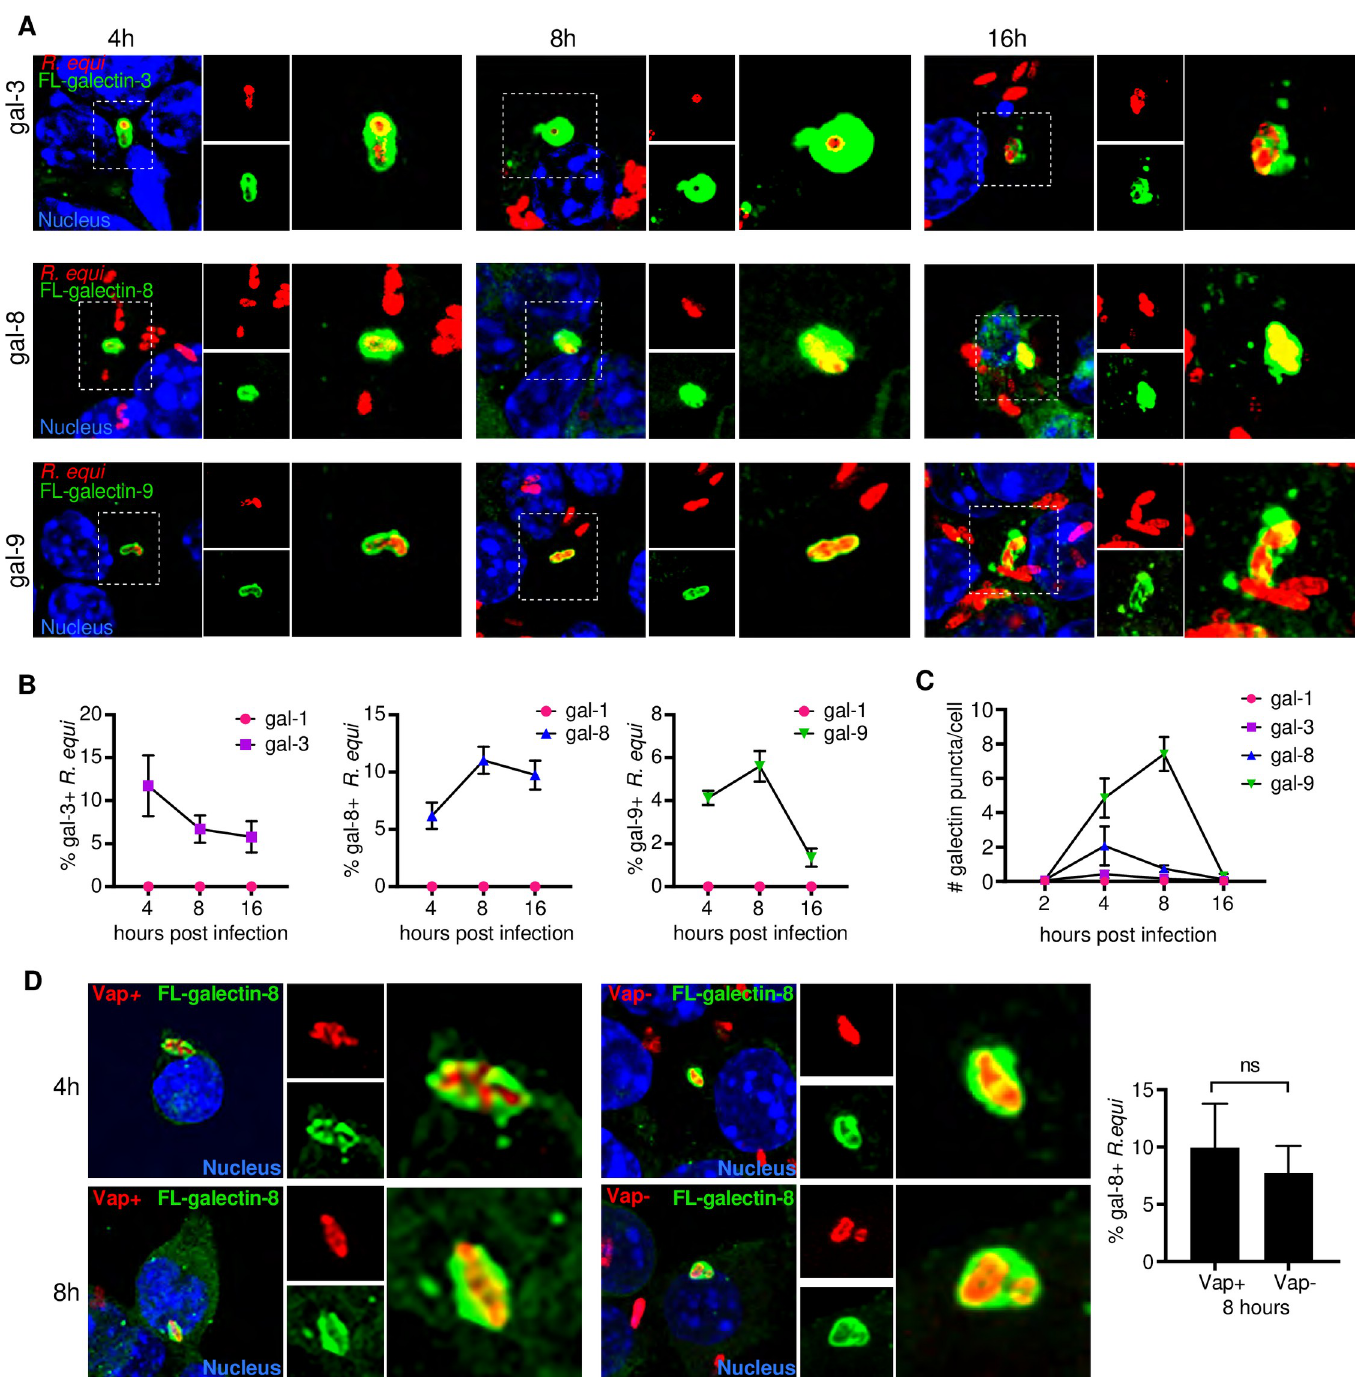
Fig 6. Galectins are recruited to R . equi . (A) Immunofluorescence (IF) of RAW 264.7 cells stably expressing 3XFLAG (FL)-tagged galectin-3, -8, or -9 infected with GFP expressing R . equi 103+ (MOI-5) for the indicated times. (B) Quantification of galectin-1, -3, -8, or -9 recruitment to R . equi at the indicated times. (C) Quantification of galectin-1, -3, -8, or -9 puncta in R . equi- infected RAW 264.7 cells at the indicated times. A minimum of 100 cells were quantified per coverslip. (D) IF of RAW 264.7 cells stably expressing 3X FL-tagged galectin-8 infected with GFP expressing R . equi 103+ or 103- (MOI-5) for the indicated time and quantification of galectin-8 positive R . equi in at 8h expressed as percent of total R . equi . IF images are representative of 3 independent experiments. Quantification is the percent of positive bacteria with at least 100 bacteria quantified per coverslip. Error bars are ± SEM. Statistical significance was determined using Students’ t-test. � p < 0.05, n.s. = not significant.